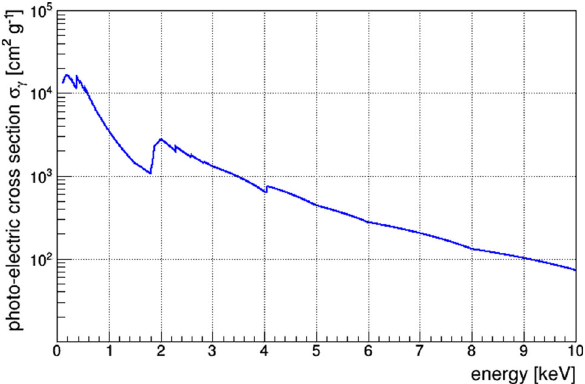
Fig. 1 Photo-electric cross section σ γ for CaWO 4 . The cross section for energies below 1keV was taken from [22], for energies above 1keV from [23]